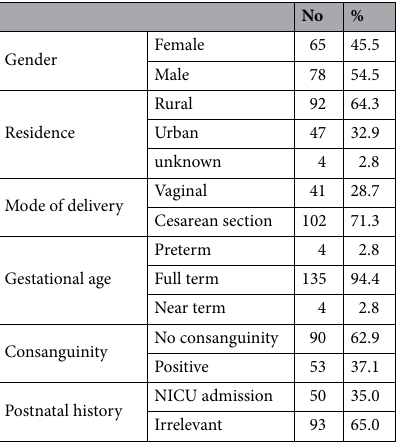
Table 1. Demographic data of the studied patients (gender, residence, mode of delivery, gestational age, consanguinity, and postnatal history).